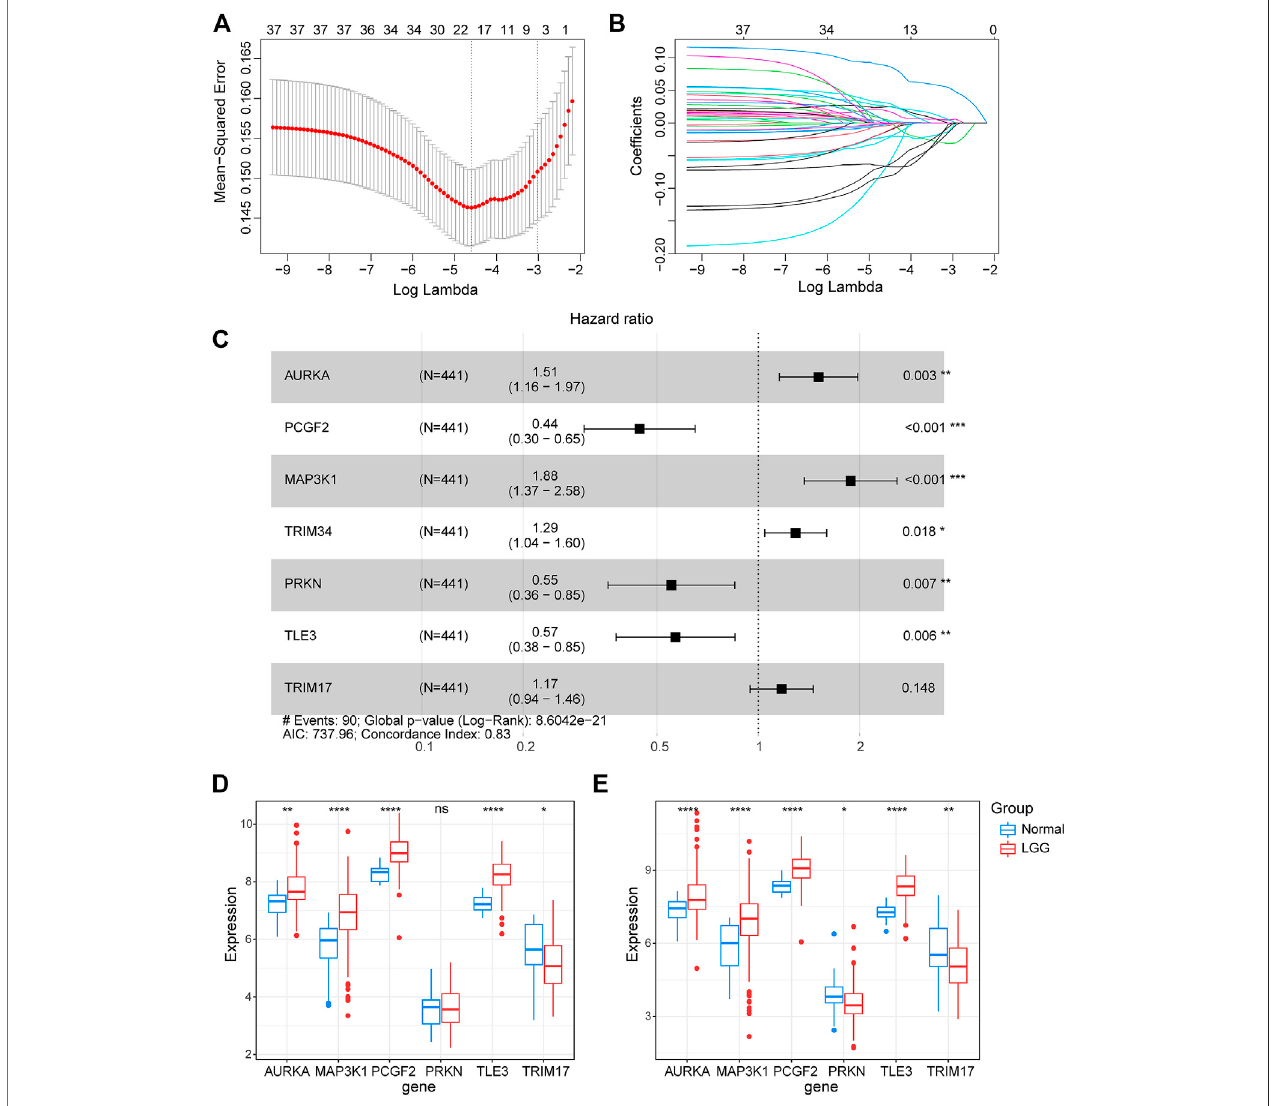
FIGURE 3 | Construction of the prognostic E3-related signature. (A) LASSO regression cross-validation for tuning parameter lambda selection. (B) Coef fi cient pro fi les of the LASSO regression analysis. (C) Seven optimal prognostic E3-related DEGs selected by multivariate Cox regression analysis are shown in the forest plot. (D) Expression of the signature genes in the GSE4290 dataset. (E) Expression of the signature genes in the GSE68848 dataset. (* p < 0.05; ** p < 0.01; *** p < 0.001; **** p < 0.0001; ns, not signi fi cant).